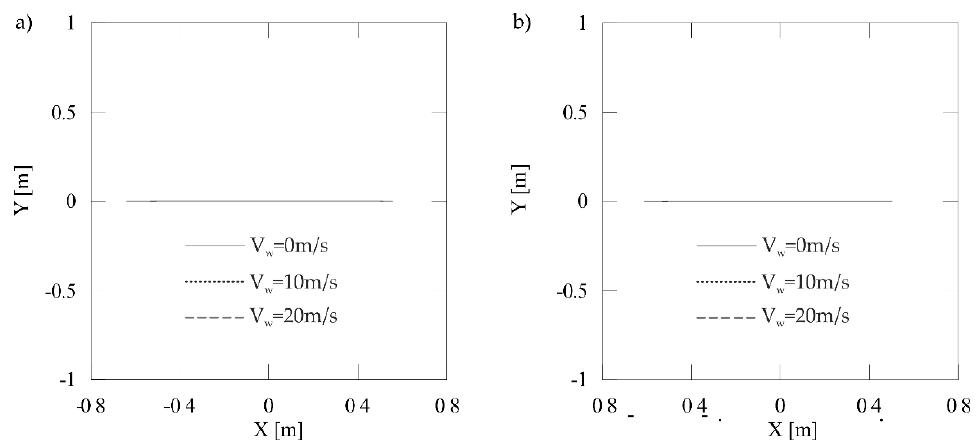
Figure 3. Projection of the trajectory of the carried load’s suspension point on the rotation plane for ( a ) the variable effective area and ( b ) fixed effective area.